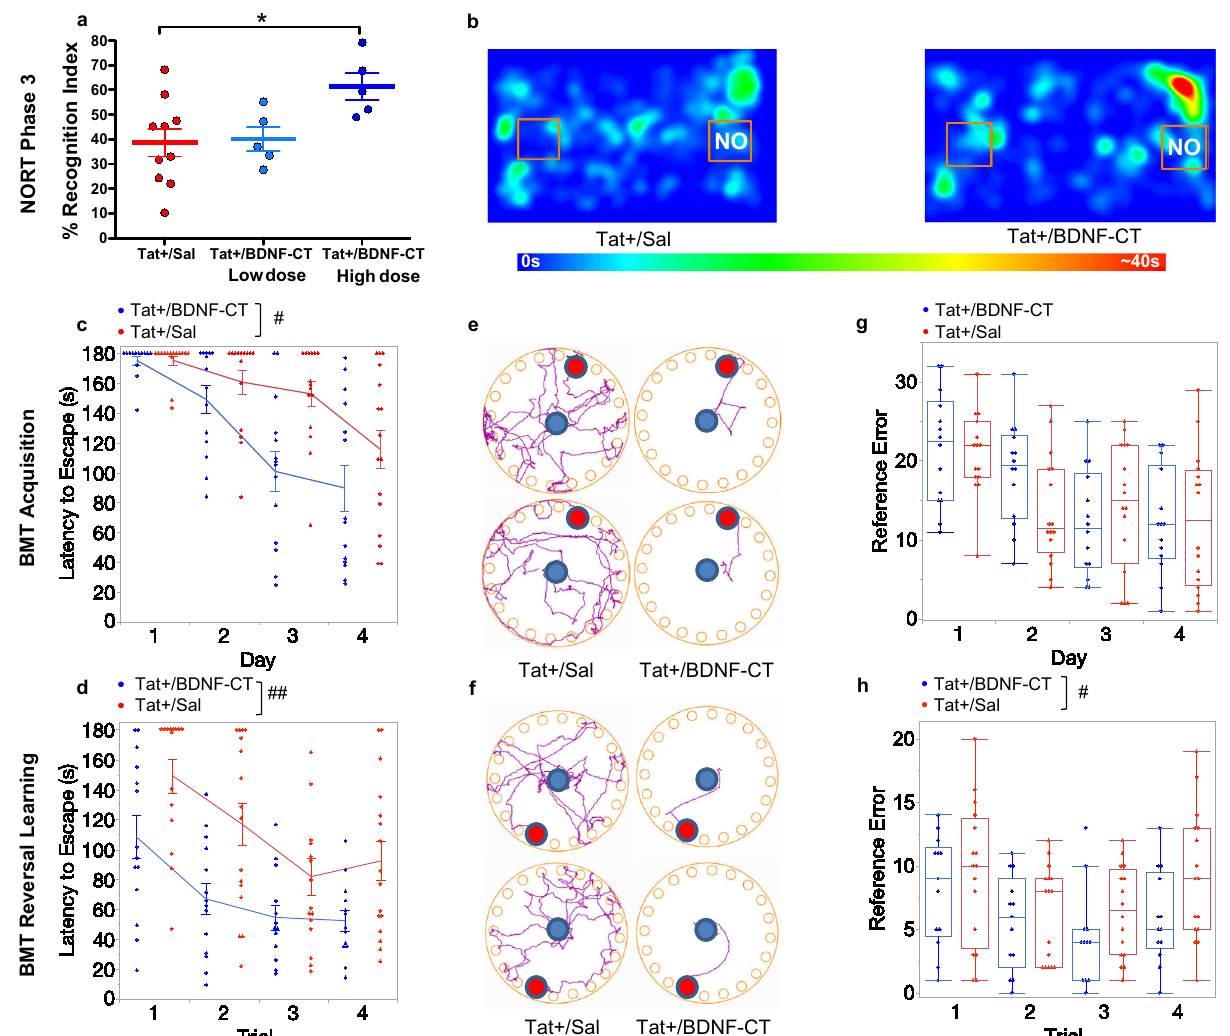
Fig. 7 BDNF-CT ameliorated Tat-induced learning and memory de fi cits and enhanced cognitive fl exibility in the Novel object recognition test (NORT) and Barnes maze test (BMT). Tat + mice received i.p. Dox (100 mg/kg) and either i.n. saline or BDNF-CT daily for 7 days. Testing procedures started on the 8th day and lasted for 5 days. ( a ) NORT Phase 3 Recognition Index (RI) was signi fi cantly higher in Tat + mice treated daily with a high dose (0.3 mg/kg of BDNF and 2.4 mg/kg of CT) but not a low dose (0.15 mg/kg of BDNF and 1.2 mg/kg of CT) of NPs compared to saline ( n = 5 – 10 per group). ( b ) Representative heat maps show time spent in different locations of the NORT testing chamber. In the BMT, the latency to locate and enter the escape hole in the acquisition ( c ) and reversal learning ( d ) phases was lower in Tat + mice treated with BDNF-CT vs. saline. Representative diagrams show paths from the starting position (blue dot) to the escape hole (red dot) on day 3 of acquisition phase ( e ) and trials 2 and 4 of reversal learning phase ( f ) (top and bottom, respectively). The number of reference errors ( g , h ) was signi fi cantly lower in BDNF-CT compared to saline treated Tat + mice only in the reversal learning phase ( h ) of BMT. Data are represented as the mean. Error bars represent S.E.M. Overall treatment differences in the BMT are indicated by # P < 0.05 and ## P < 0.01. Between-subjects post hoc analysis in the NORT is indicated by * P <